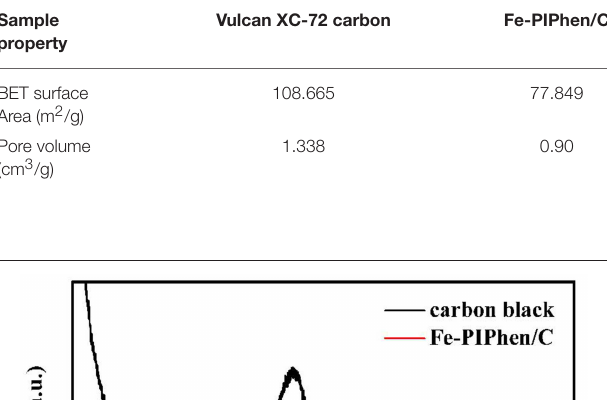
respectively. The two parameters of Fe-PIPhen/C decrease compared with that of Vulcan XC-72 carbon, which represents the successful loading of Fe-PIPhen/C (Yang et al.,